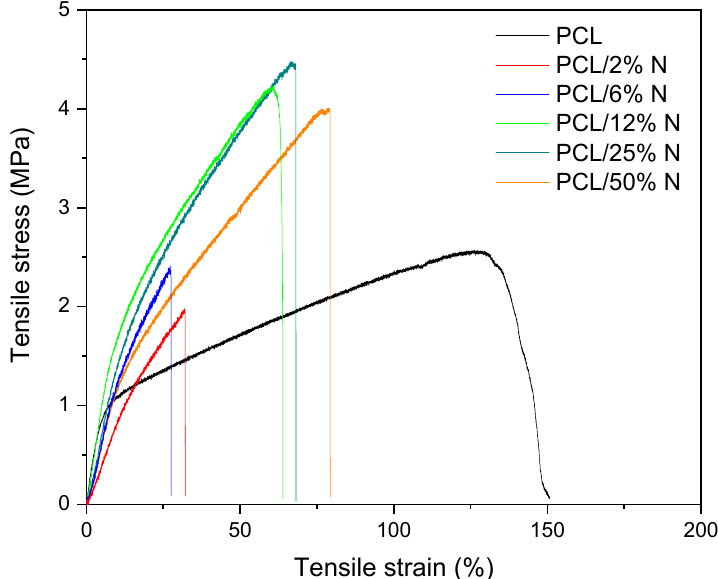
Figure 6. Stress–strain curves for plain electrospun PCL and PCL mats with different concentra- of nisin solution varied from 0 to tions of nisin solution varied from 0 to 50%. Figure 6. Stress – strain curves for plain electrospun PCL and PCL mats with different concentra- tions of nisin solution varied from 0 to 50%.